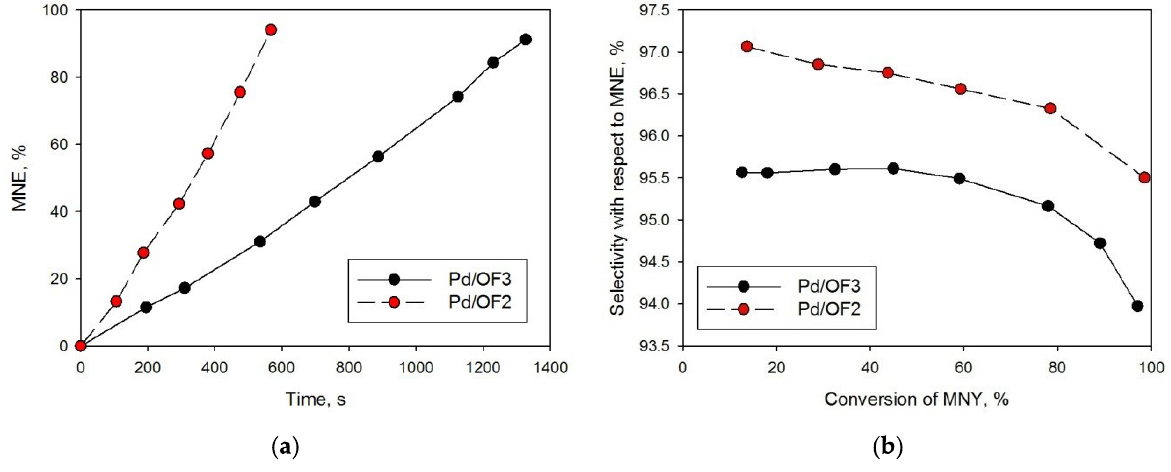
Figure 9. Kinetic curves of 3-methyl-1-nonen-3-ol (MNE) accumulation ( a ) and dependence of the selectivity, with respect to MNE on MNY conversion of ( b ).